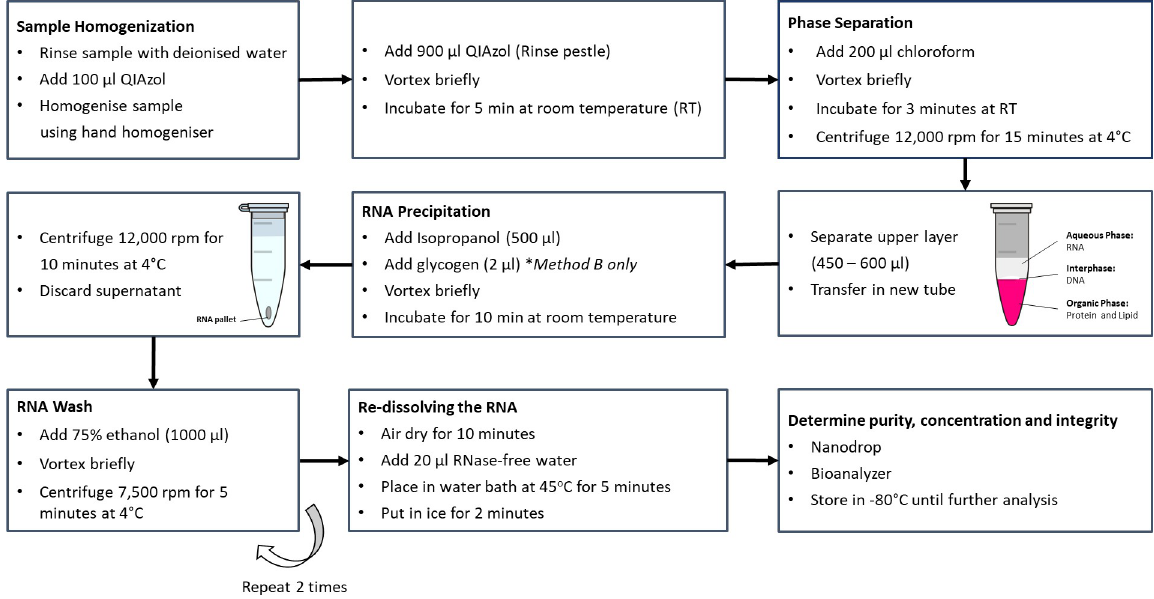
Fig 1. Method of extraction by using QIAzol (Method A) and QIAzol + glycogen (Method B).